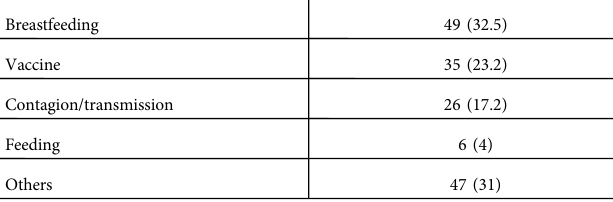
TABLE 3 Caregivers in fl uenced by hoaxes ( n